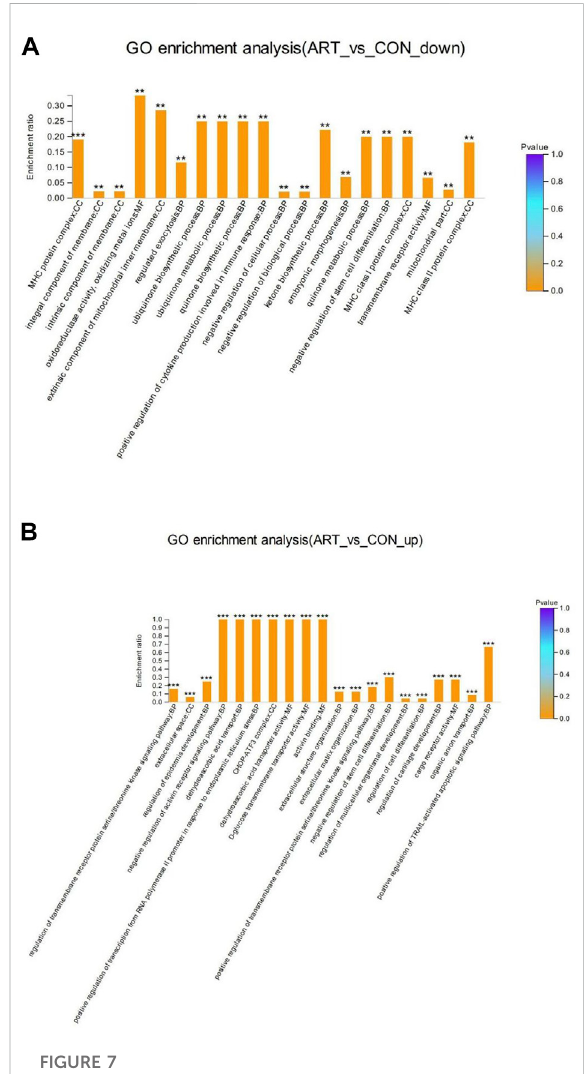
FIGURE 7 GO enrichment analysis of DSEPs in the artemisinin treatment group vs. the control group. (A) GO enrichment analysis of upregulated DSEPs. (B) GO enrichment analysis of downregulated DSEPs. The x -axis represents the GO terms, while the y -axis represents the enrichment ratio, which is the ratio of the number of DSEPs in the GO term to the number of all annotated proteins in the GO term. The greater the ratio, the greater the degree of enrichment in each category. The color of the bars is related to the p value: *** p < 0.001, ** p < 0.01, and* p <